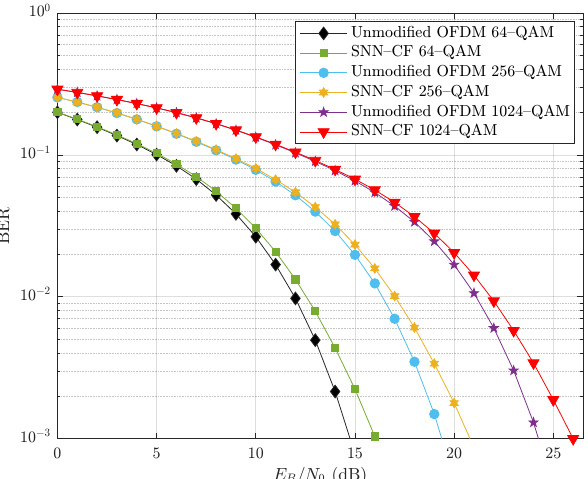
Figure 11. BER performance tracking of the proposed SNN-CF scheme for higher order modulations: 64-QAM, 256-QAM, and